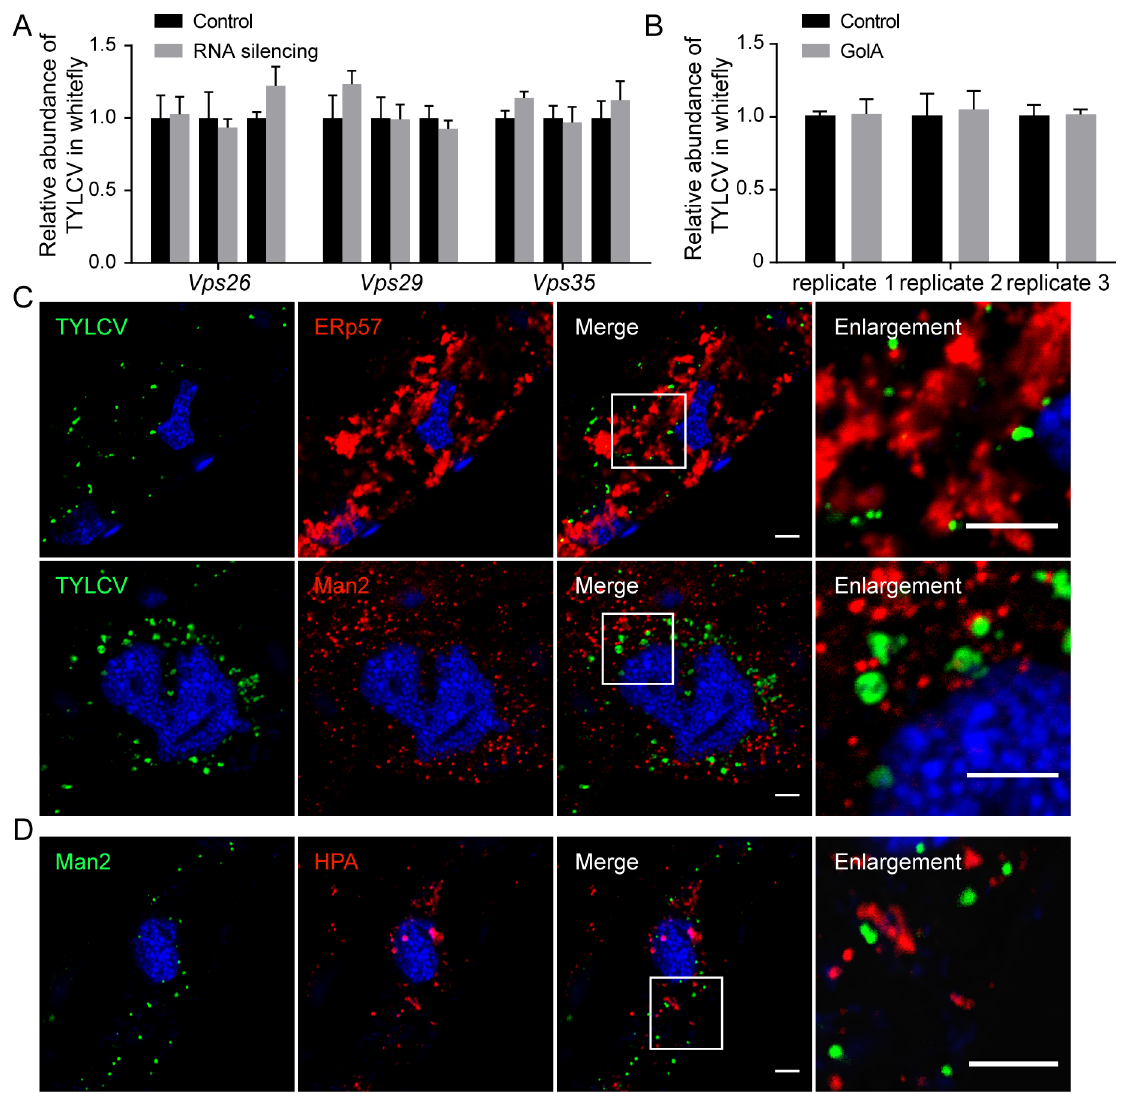
Fig 5. Lack of evidence for the involvement of Golgi apparatus in TYLCV trafficking. (A) TYLCV trafficking was not influenced by silencing Golgi apparatus-related genes. After gene silencing, whiteflies were transferred to TYLCV-infected plants for virus acquisition. The abundance of virus in the whiteflies was quantified 48 h later and compared with that in controls injected with dsRNA of GFP (n = 4–7). (B) Effect of GolA on virus acquisition. Whiteflies were fed with GolA for 24 h to disrupt the function of the Golgi apparatus and transferred to TYLCV-infected plants. The abundance of virus in the whiteflies was measured after 48 h by quantitative PCR and compared with that in solvent-fed controls (n = 4). (C) Midguts of whiteflies exposed to TYLCV-infected tomato plants for a 3 d AAP were dissected and prepared for immunofluorescence. The ER and Golgi apparatus were identified using antibodies against ERp57 and alpha-mannosidase 2 (Man2), respectively. Colocalization between TYLCV and ERp57 or Man2 was quantified as 0.05 ± 0.01, 0.03 ± 0.01, respectively (Pearson’s coefficient, mean ± SE, n = 17–33). Scale bar, 5 μm. (D) The midguts of whiteflies were dissected and labeled by HPA lectin and antibody against Man2. Their colocalization was quantified as 0.10 ± 0.01 (Pearson’s coefficient, mean ± SE, n = 10). Scale bar, 5 μm. Representative images that were used to generate the data are provided in S8 Fig. Data shown are mean ±